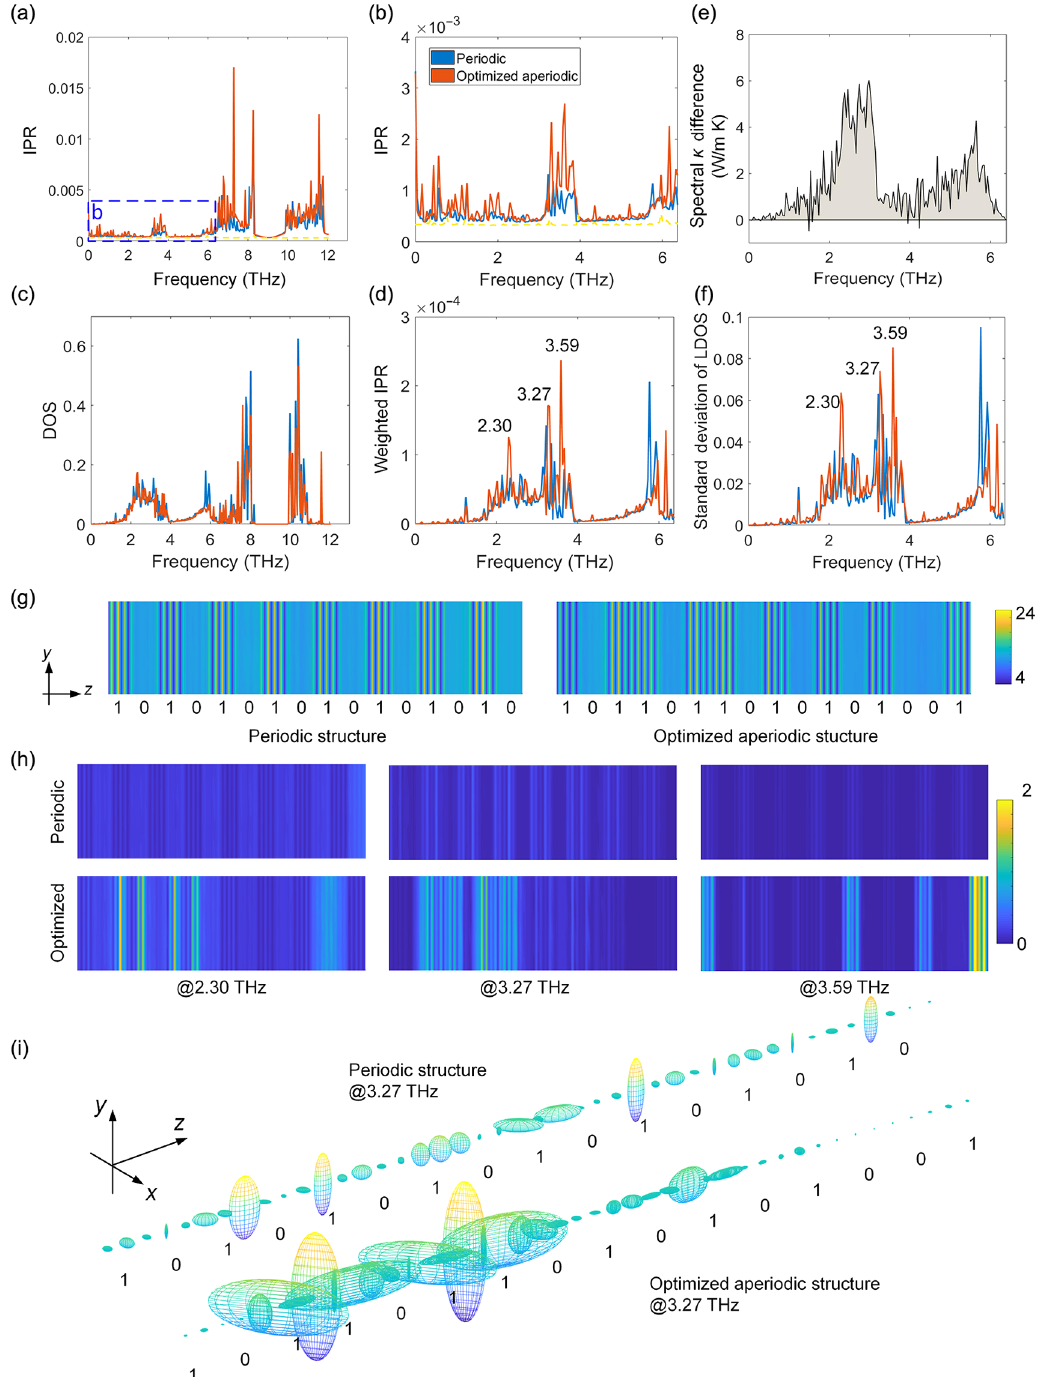
FIG. 4. Phonon-localization analyses of the periodic and the optimized aperiodic structures. Comparison of the frequency-dependent inverse participation ratios (IPR) I ð ω Þ of the two structures in the (a) full and (b) acoustic phonon frequency ranges. Blue-dashed square in (a) denotes the acoustic phonon range and is magnified in (b). Yellow-dashed lines denote the IPR for pure GaAs crystals with a small and uniform IPR. (c) Spectral DOS of the two structures in the full phonon frequency range. (d) Spectral weighted IPR in the acoustic phonon frequency range. (e) Spectral thermal conductivity difference between that of the periodic structure and that of the optimized aperiodic structure. (f) Spectral standard deviation of LDOS of the two structures in the acoustic phonon frequency range. (g) Projected LDOS distribution on the y - z plane with only the acoustic phonons in the periodic and the optimized aperiodic structures. (h) Projected LDOS in the y - z plane of the two structures at 2.30, 3.27, and 3.59 THz. (i) Strength of the phonon localization along the thickness direction ( z axis) of the two structures at 3.27 THz. Length of the ellipsoids denotes the averaged LDOS in the x , y , and z directions in each